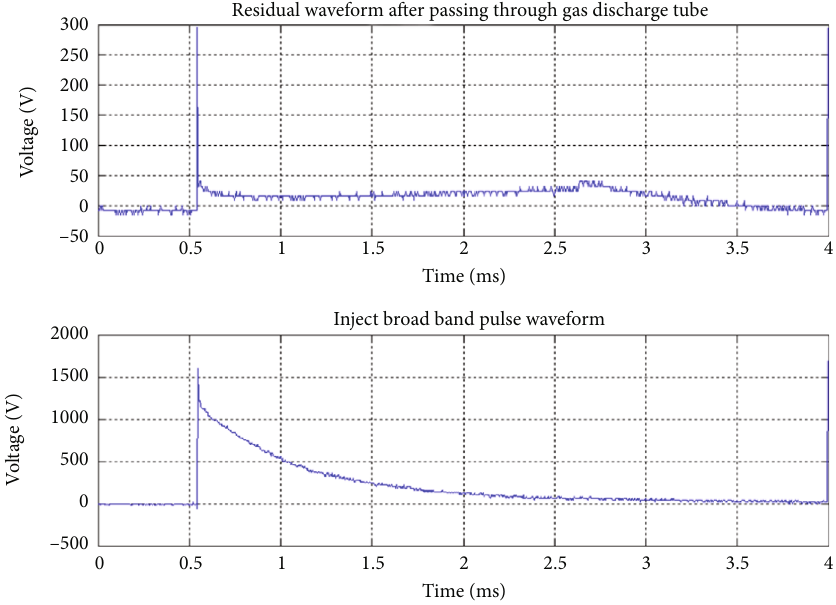
Figure 2: Waveforms before and after wide pulse input to gas discharge tube.